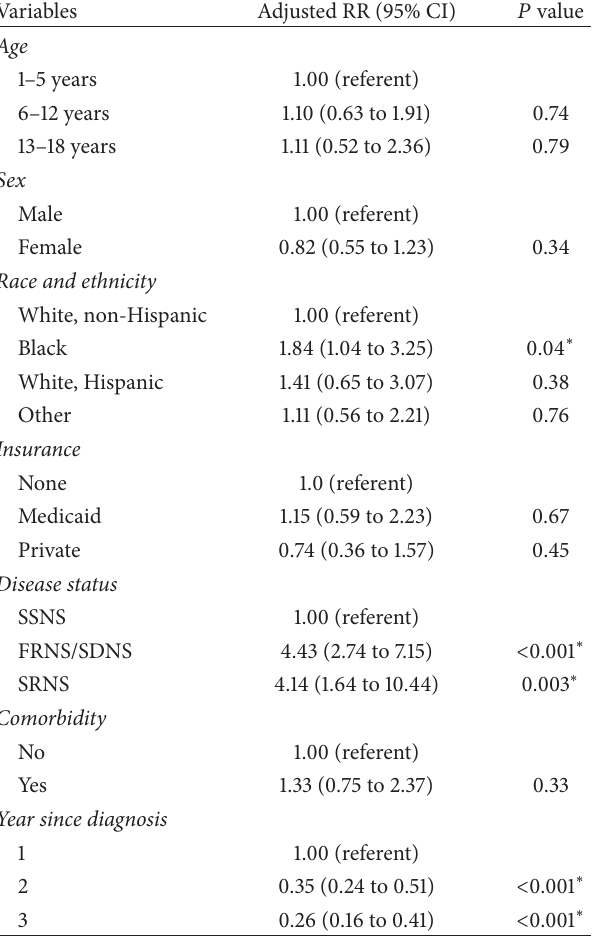
Table 4: Association between patient characteristics and length of stay among hospitalized